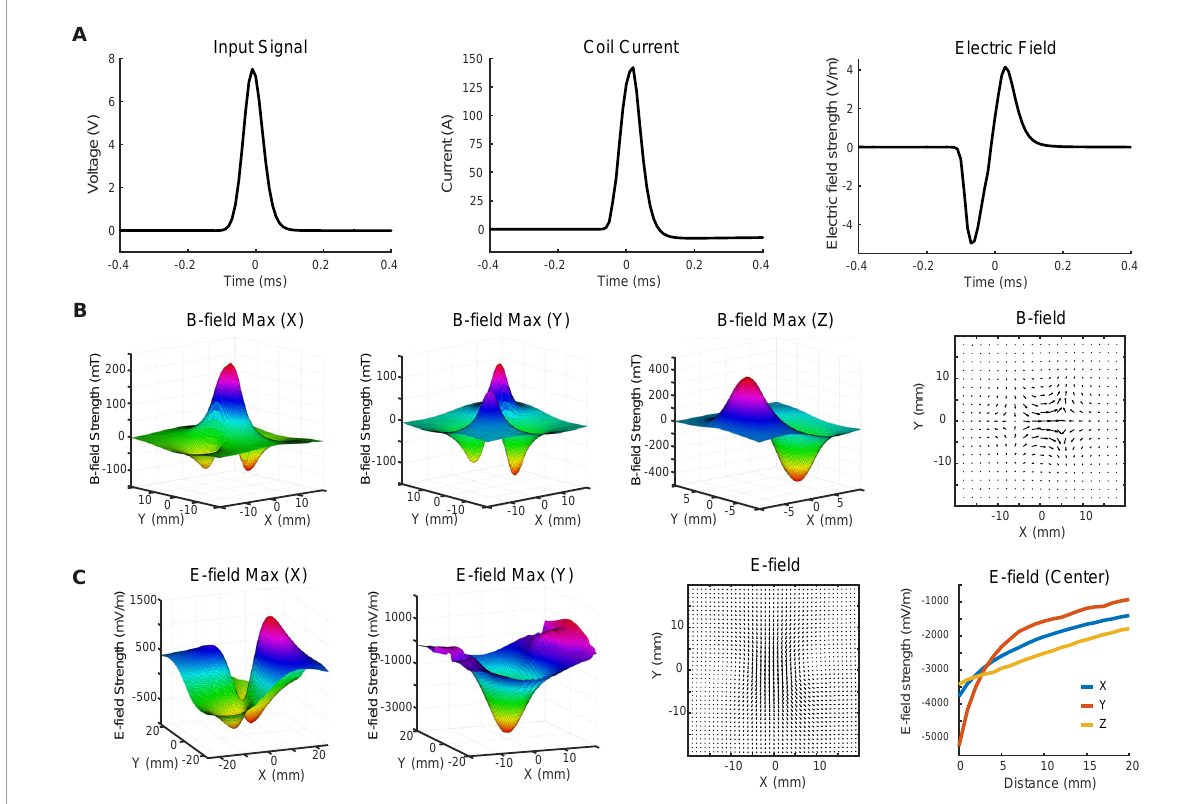
FIGURE3 Magnetoelectric fields induced by the TMS coil. (A) Input signal to the coil (left), coil current (middle), and induced biphasic voltage waveform (right) measured on benchtop and in saline. (B) x-, y-, and z-components of the magnetic field measured with the search coil at maximum intensity (z = 0). The total magnetic field in the horizontal (x-y) plane is depicted in the vector plot. (C) x- and y-components of the electric field measured in saline with the dipole probe positioned 4 mm above the coil at maximum intensity. The total electric field in the horizontal plane is depicted in the vector plot. x-, y-, and z-components of electric field at different distances (0–20 mm) were measured at the center of the coil.